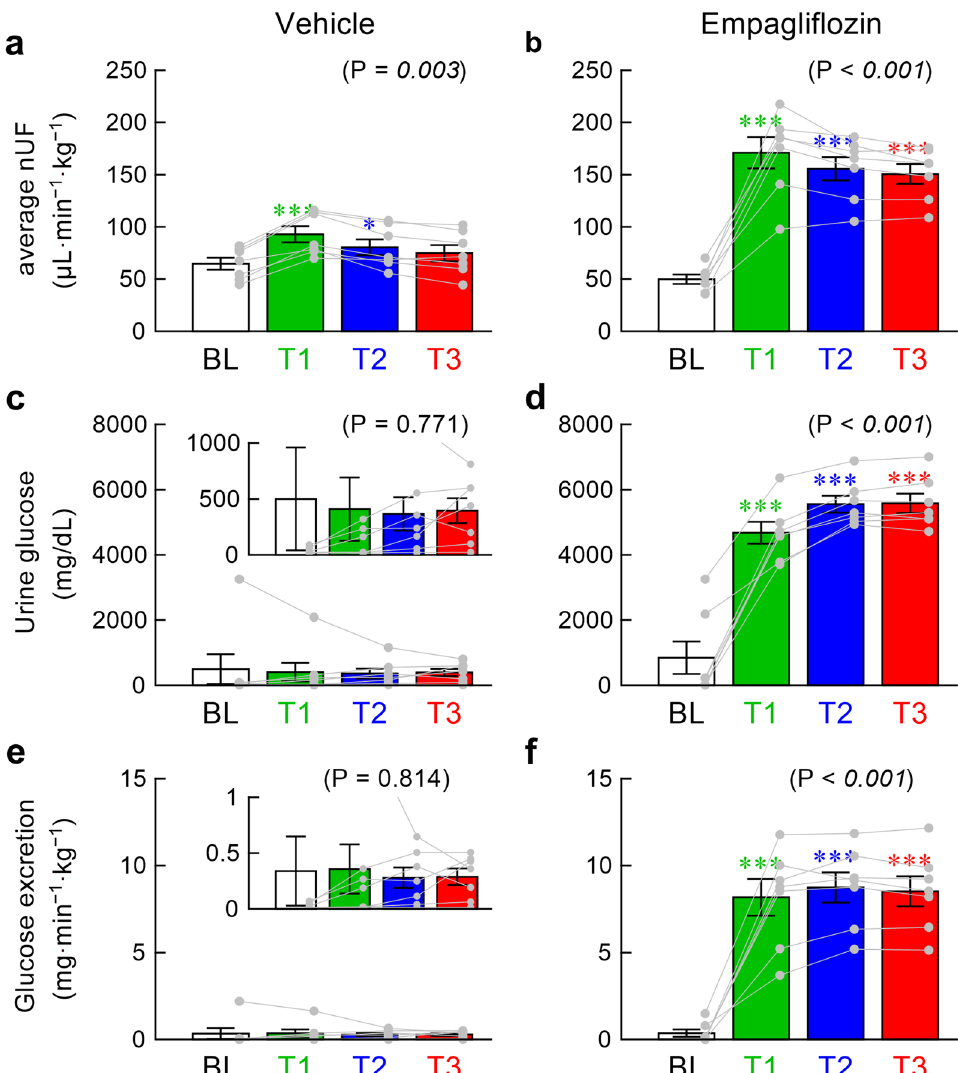
Fig. 3 The top panels illustrate the averaged normalized urine flow (nUF) during baseline (BL), T1, T2, and T3 periods obtained in the vehicle ( a ) and empagliflozin ( b ) groups. The middle panels illustrate the urine glucose concentration during BL, T1, T2, and T3 periods obtained in the vehicle ( c ) and empagliflozin ( d ) groups. The bottom panels illustrate the urine glucose excretion during BL, T1, T2, and T3 periods obtained in the vehicle ( e ) and empagliflozin ( f ) groups. Data are presented as mean SE values with data points of the respective rats (n 7 rats each). In panels c , e , the ± = insets indicate the enlarged ordinates. In each panel, the P value of the repeated-measures one-way analysis of variance (ANOVA) is shown in the parenthesis. The value is italicized when P < 0.05. Symbols * and *** indicate P < 0.05 and P < 0.001 from BL by the post hoc Dunnett’s